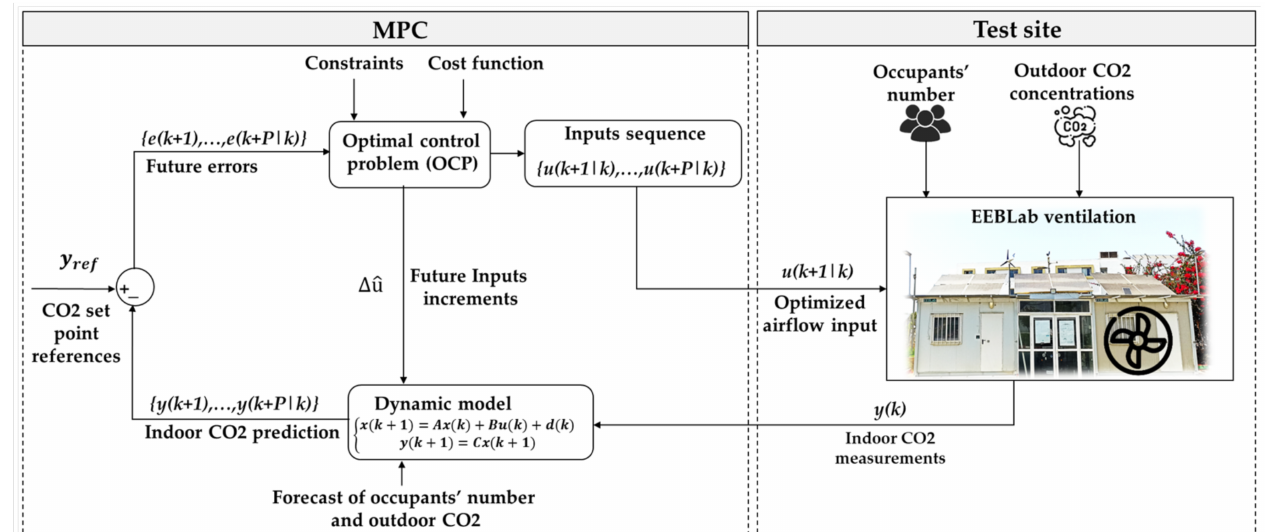
Figure 8. The general structure of the MPC framework for the EEBLab ventilation control system. The prediction and control horizons used in the MPC framework are respectively P = 10 (i.e., 300 s) and M = 5 (i.e., 150 s) steps ahead. For occupancy, the forecasted number is used to control the indoor CO 2 dynamics, including the CO 2 generated by the occupants over the horizon P. The forecast of the occupants’ number and measurements of the indoor/outdoor CO 2 are forwarded to the OCP. The optimized control